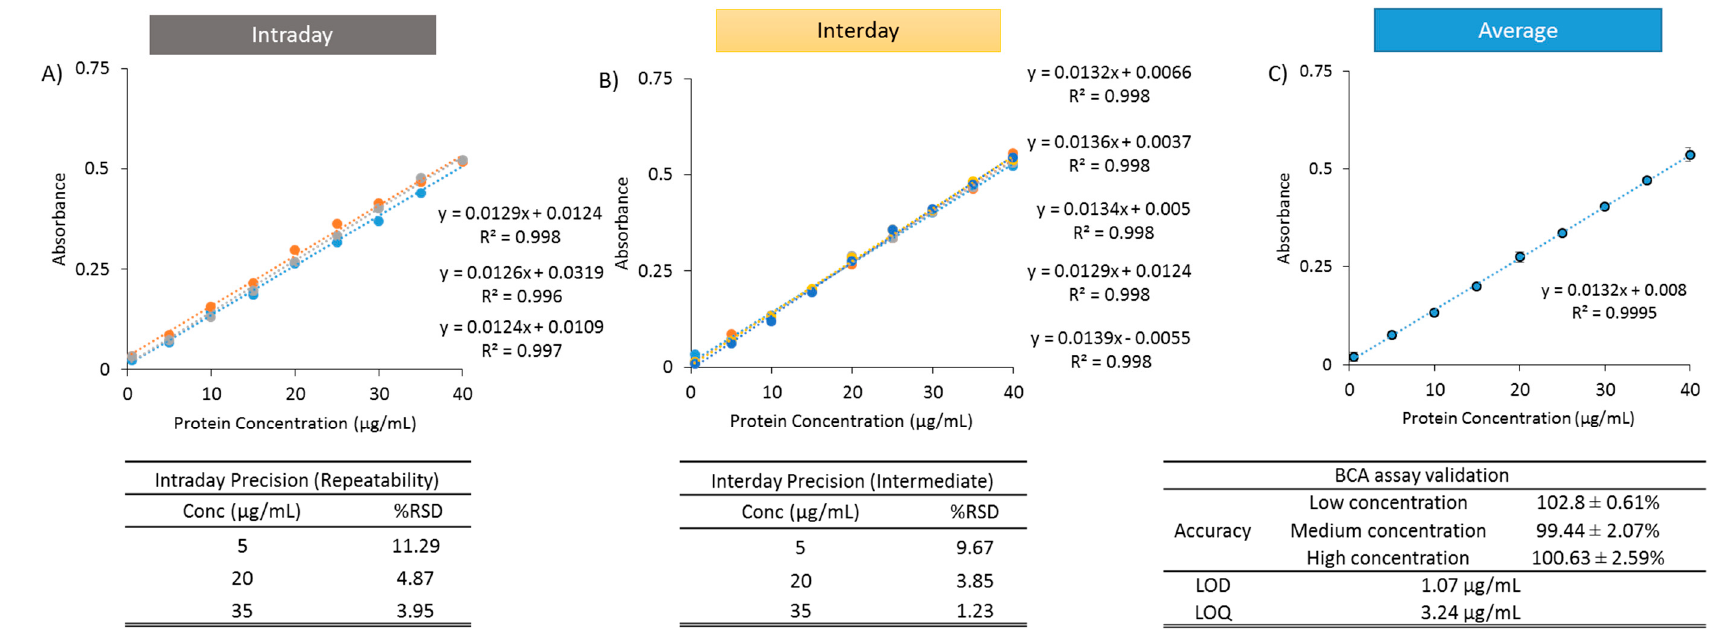
Figure 3. Ovalbumin calibration curves in water in the presence of liposomes (DSPC:Chol 10:5 wt/wt; at a fixed final concentration of 1 mg/mL). The LOD and LOQ values were established using micro BCA, following empty liposome blank removal. Intraday curves were generated ( A ) within the same day, while Interday curves were generated over 5 separate days ( B ) along with the average ( C ). Accuracy was determined at three concentrations, while Intra-day and Inter-day precision was calculated across three different concentrations, with %RSD shown.